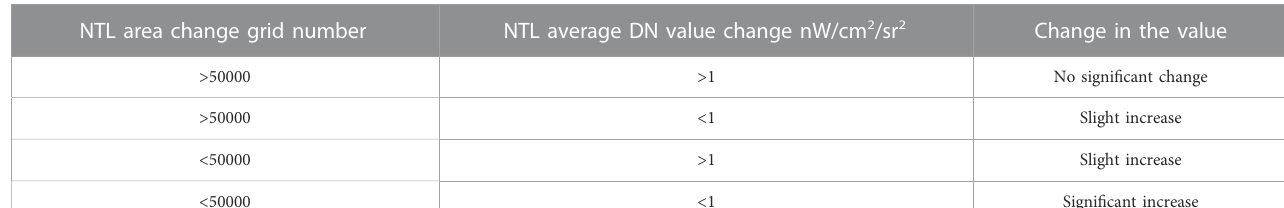
TABLE 1 Classi fi cation of changes in the refugee population.